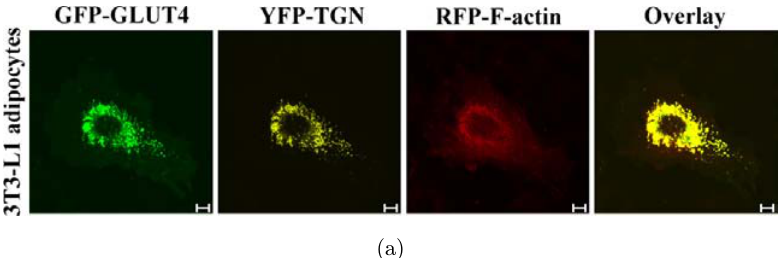
Fig. 1. Subcellular localization of GLUT4. 3T3-L1 adipocytes were co-transfected with GFP-GLUT4, YFP-TGN38 and RFP- F-actin expression plasmids. About 48 h later, the transfected cells were observed with confocal microscopy. (a) The localization of GLUT4 in 3T3-L1 adipocytes. GLUT4 (green emission) was co-localized with Golgi apparatus (yellow emission). Bar ¼ 10 (cid:4) m. (b) 3T3-L1 adipocytes were treated with or without insulin (1 nM) and the localization of GLUT4 was observed. GLUT4 was localized to the cytomembrane. Bar ¼ 10 (cid:4)